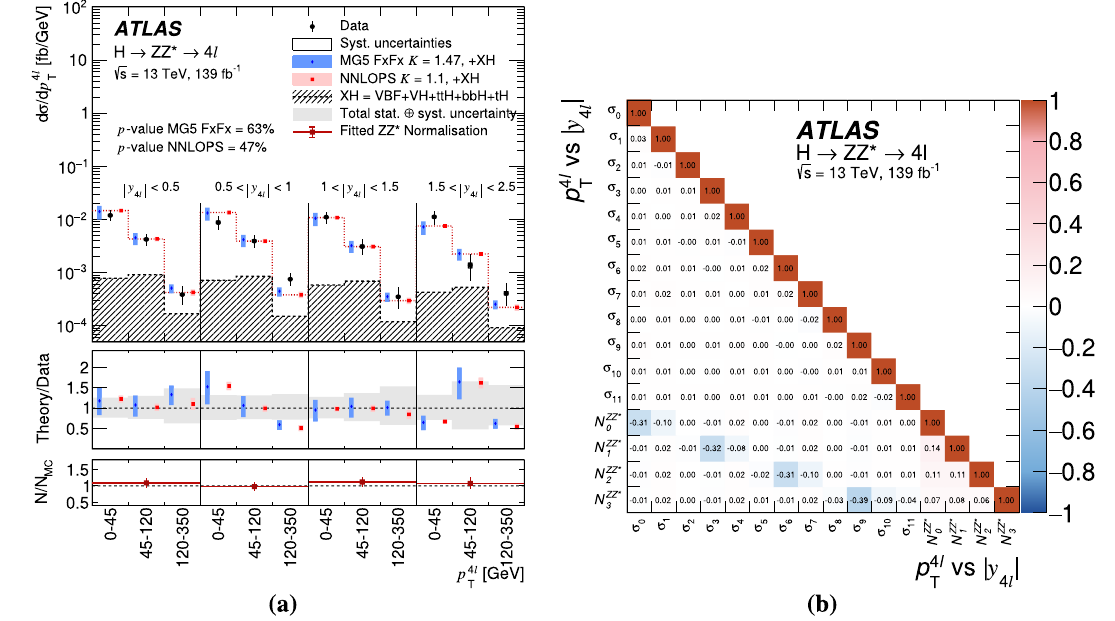
Fig. 33 a Doubledifferentialfiducialcrosssectionsofthe p 4 (cid:3) cross sections and the Z Z ∗ background normalisation factors is shown in b . The p -values shown are calculated for all bins across both p 4 (cid:3) | y | simultaneously 4 (cid:3)